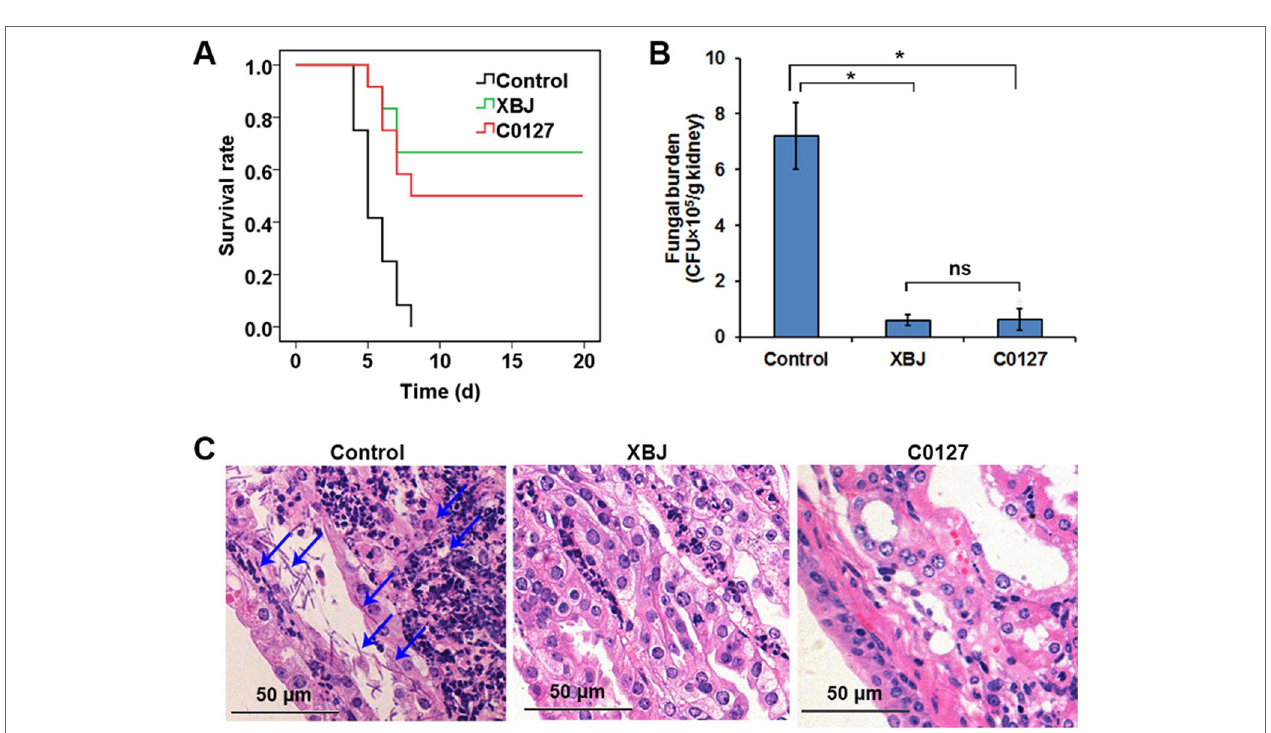
FIGURE 7 | Key compounds (C0127) in XBJ rescued mice from lethal infection of C. albicans . (a) Survival curves of different groups of mice in Candida infected (Control) and treatment groups. Control vs. XBJ and Control vs. C0127: P < 0.05. Control group: N = 11; XBJ and C0127 group: N = 12. (B) Colony-forming assay to evaluate fungal load in kidneys 4 days after Candida infection. * P < 0.05. (C) Hematoxylin and eosin staining to determine the histology in kidneys. Arrows indicated fungal hyphae in an infected